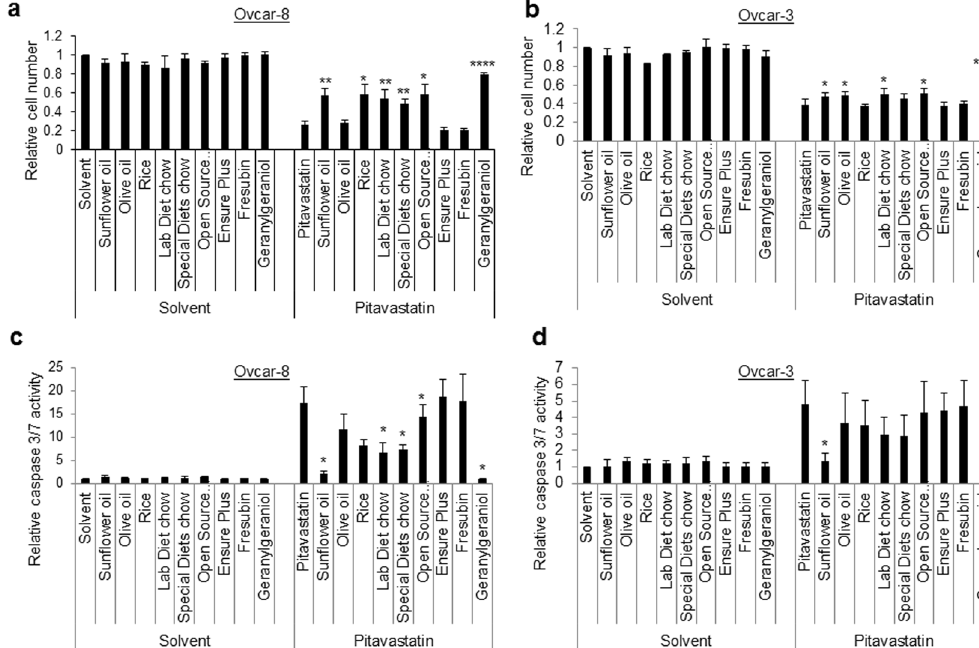
Figure 4. Ovcar-8 ( a , c ) or Ovcar-3 ( b , d ) cells were exposed to pitavastatin (1 μ M) in the presence of solvent extracts (0.06% v/v) from the indicated human foodstuffs and mouse chow from different suppliers. ( a , b ) The number of cells remaining (mean ± S.D., expressed as a fraction of cells treated with solvent alone, n = 3–5 biological replicates) after 72 h was determined by staining with SRB. The number of cells was significantly different to cells exposed to pitavastatin alone where indicated (paired t -test, * P < 0.05; ** P < 0.005; *** P < 1 × 10 − 4 ; **** P < 5 × 10 − 6 ). ( c , d ) Cells were exposed to pitavastatin and the solvent extracts as above and caspase 3/7 activity measured (mean ± S.D., n = 3 biological replicates, * significantly different from cells treated with pitavastatin alone, paired t -test, P < 0.05).